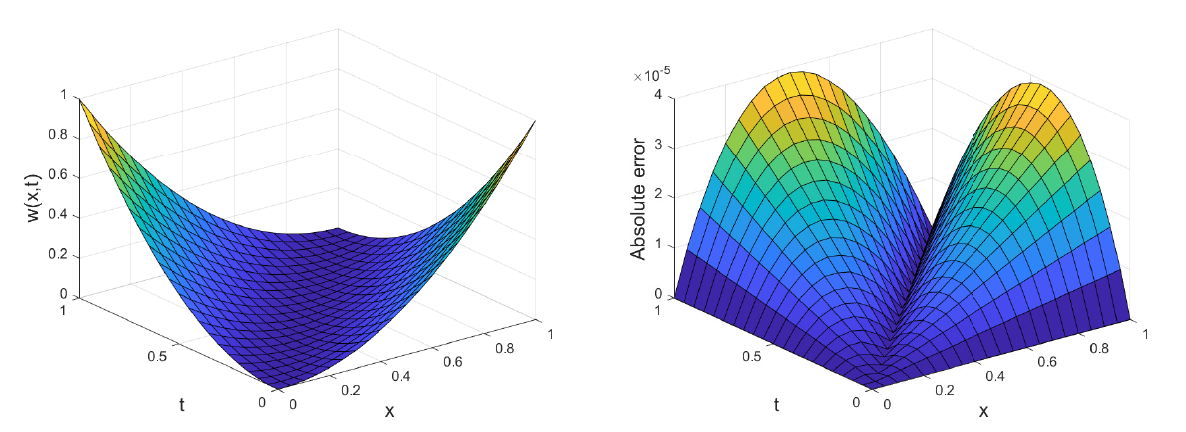
Figure 5. Plot of the approximate solution ( left ) and L ∞ errors ( right ) taking r = 5 and J = 2 for Example 2.